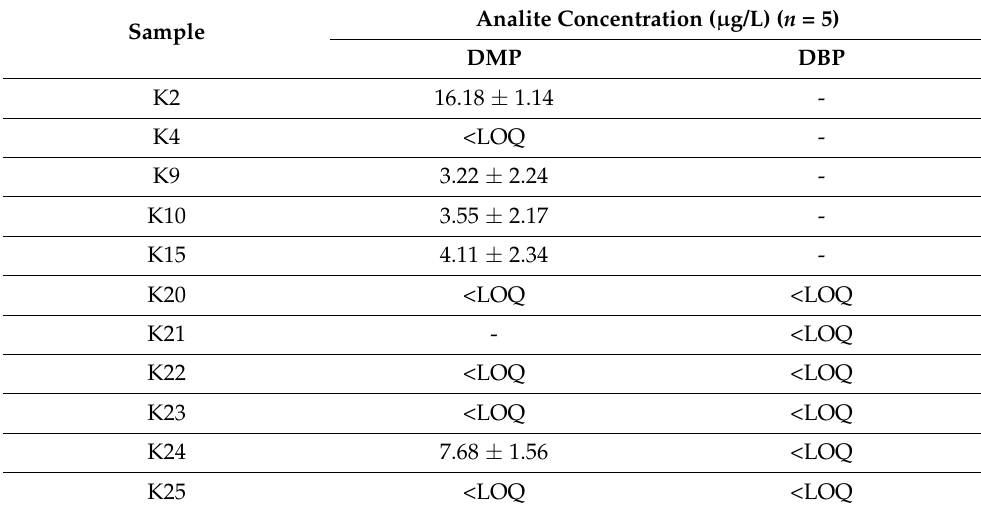
Table 3. Results of the analysis of kombucha samples using the NaHDES-VA-LLME-UHPLC- MS/MS